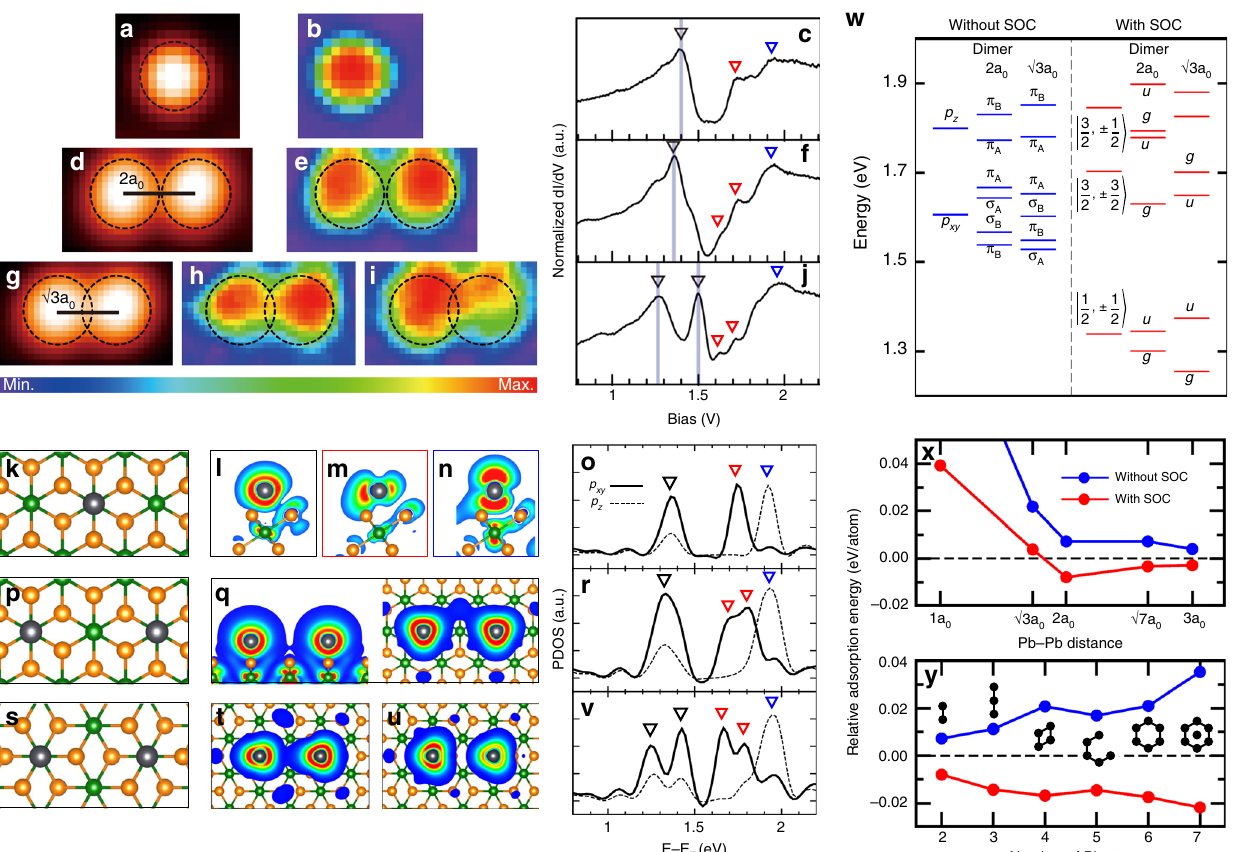
Fig. 2 Relativistic effects for the Pb monomer and dimers on IrTe 2 . a , d , g STM topography images, b , e , h , i dI / dV maps, and c , f , j STS spectra for a ffiffiffi p Pb monomer, a 2a 0 -spaced dimer, and a 3 a 0 -spaced dimer, respectively. The dI / dV maps were obtained at the peak positions of STS spectra marked by the inverted black triangles. The corresponding theoretical results are presented in k – v . k , p , s Atomic structures, l – n , q , t , u charge density plots, and o , r , v projected density of states (DOS) for a Pb monomer on the IrTe 2 -(5 × 5) supercell, a 2a 0 -spaced dimer, and a Gray, orange, and green balls in atomic structures represent Pb, Te, and Ir atoms, respectively. Charge densities were obtained for the peak energies of the DOS, three peaks for a monomer, the lowest-energy peak (top and side view) for a 2a 0 -spaced dimer, and the two lowest-energy peaks for a dimer. w DFT energy level at Γ point of a Pb monomer and dimers on IrTe 2 -(5 × 5) without and with spin – orbit coupling (SOC). For better comparison with experiments, the Fermi level of the Pb/IrTe 2 surface is shifted down by 0.7 eV. Relative adsorption energy per Pb atom of x a Pb dimer on IrTe 2 -(7 × 7) as a function of Pb – Pb distance and y various Pb molecules with a Pb – Pb distance of 2a 0 . The adsorption energy of isolated Pb atom set to zero. Blue and red data denote the cases without and with SOC,